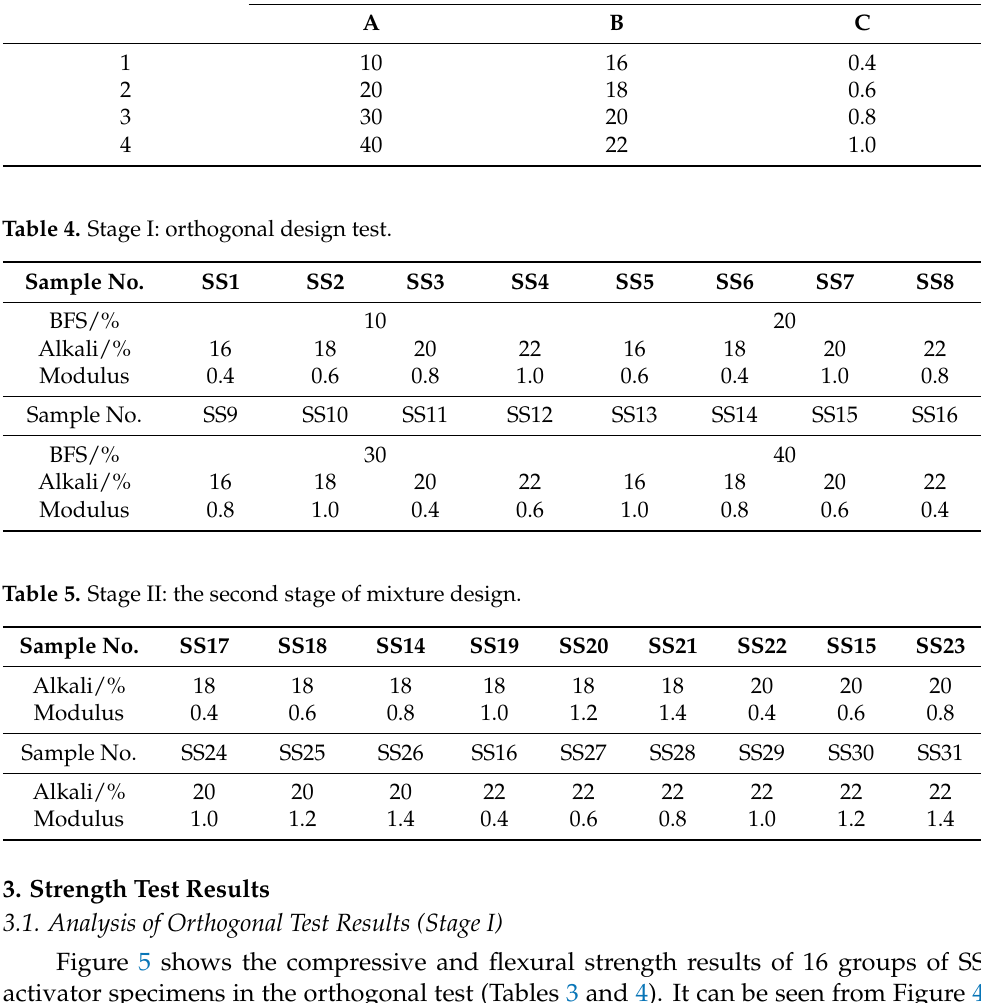
Table 3. Stage I: orthogonal experimental factors and levels.